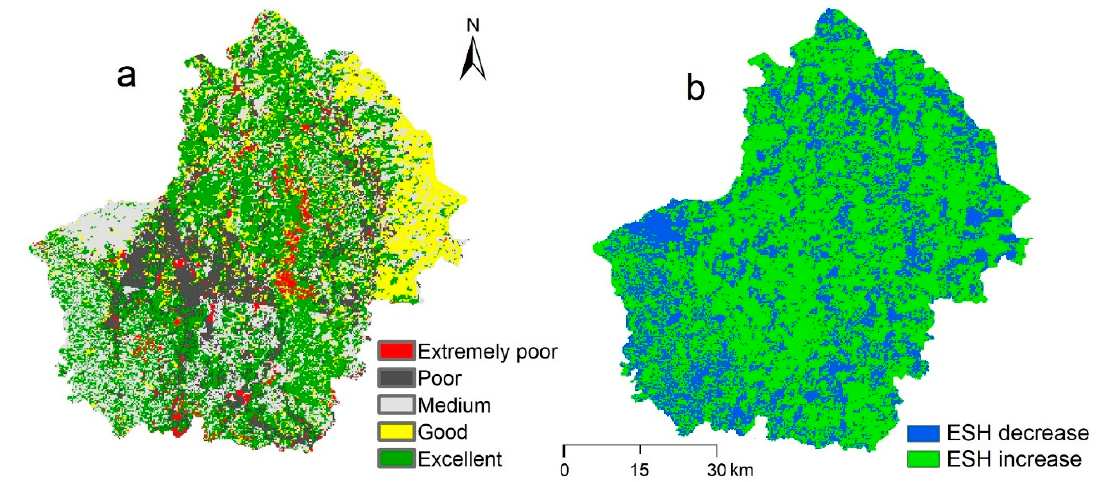
Figure 5. ESH assessment for the study area. ( a ) is the ESH index for 2005; ( b ) is the changes in ESH between 2005 and 2015.